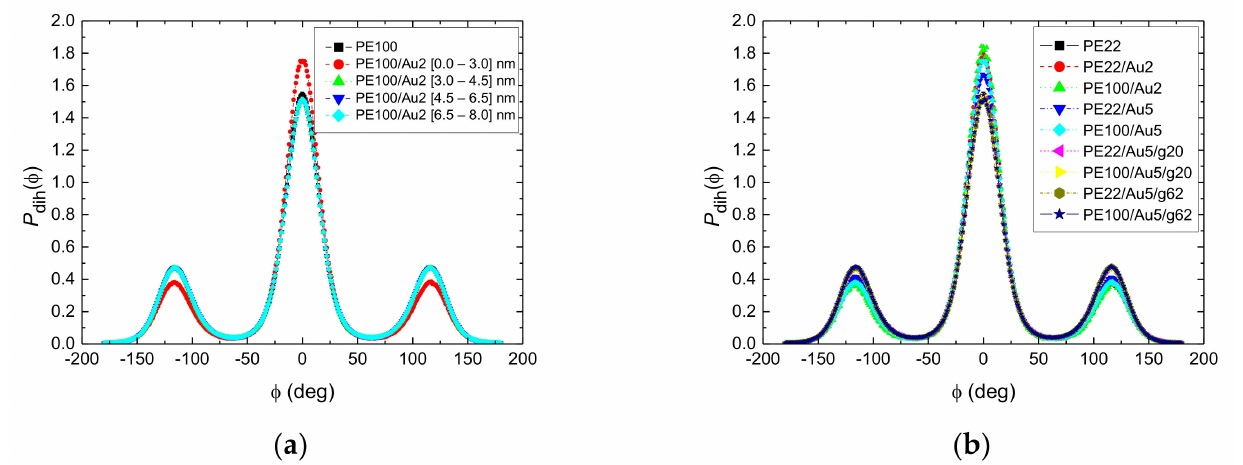
Figure 6. ( a ) Torsional angles distribution of PE chains for various distances from the center of the gold NP for the PE100/Au2 system and the corresponding PE bulk curve. ( b ) Torsional angles distributions of all model systems for PE chains belonging in the first adsorbed layer, i.e., being closer to the Au NP. The corresponding curves for bulk PE are also